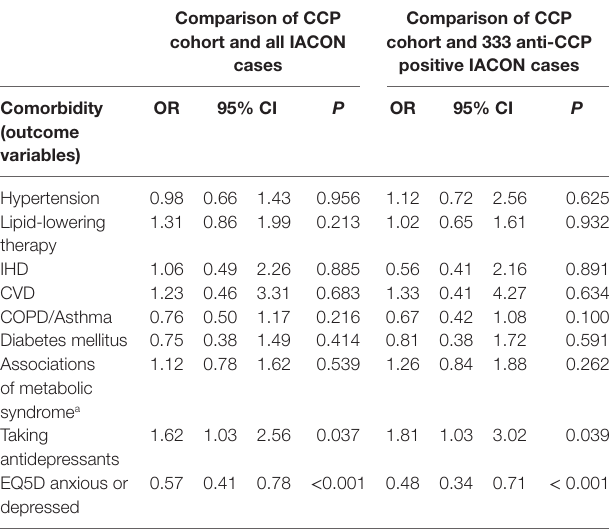
Table 2 | Results of logistic regression models of the presence of comorbidities in the cyclic citrullinated peptide (CCP) cohort, compared to IACON. comparison of ccP cohort and all